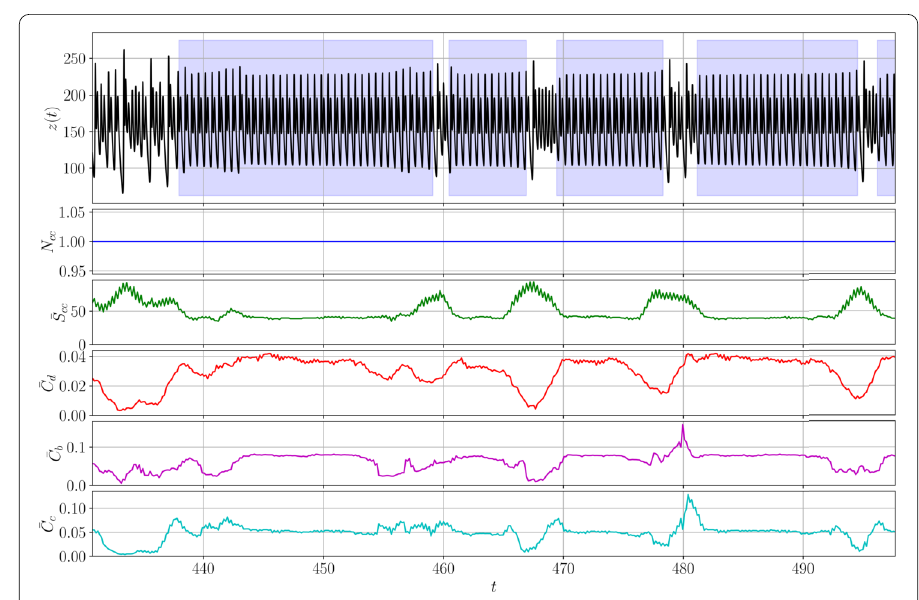
Figure 11 Connectivity and centrality analysis on temporal ordinal partition network with periodic regions as labeled with the zigzag persistence points highlighted in blue